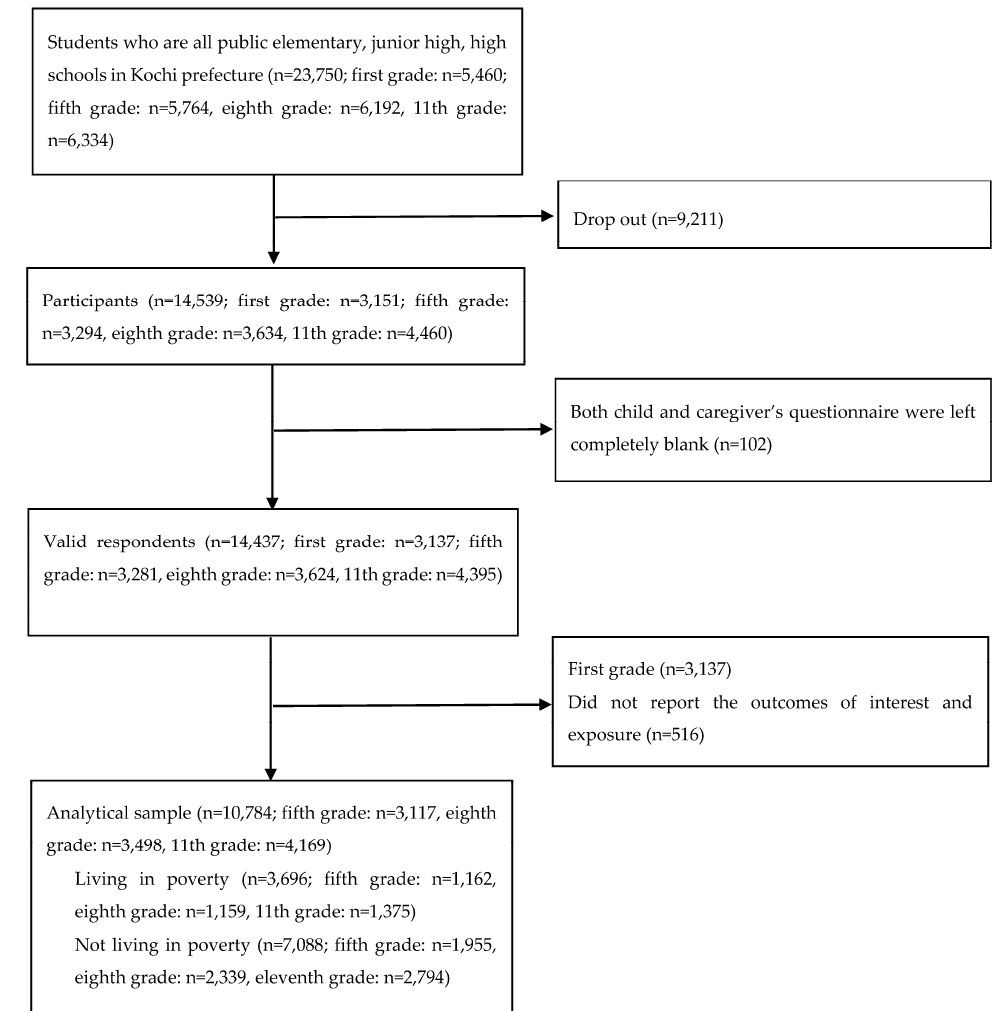
Figure 1. Requirement flow chart.